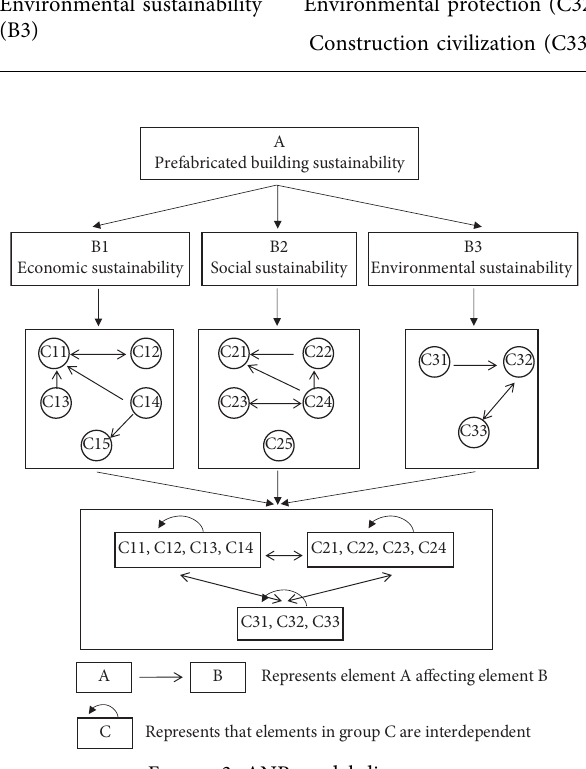
Figure 3: ANP model